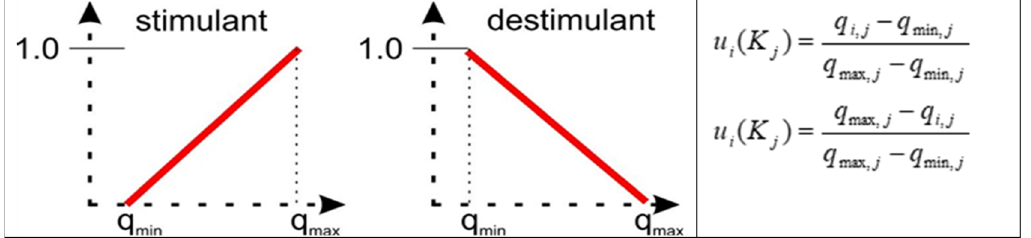
Figure 10. Normalization of stimulants and destimulants.